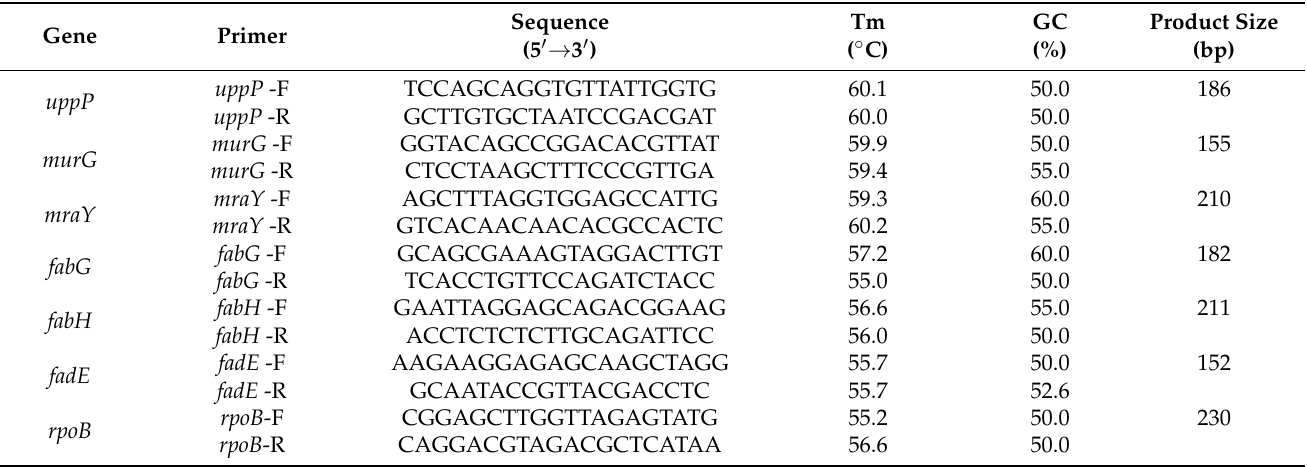
Table 1. Primer sequences for RT-qPCR.